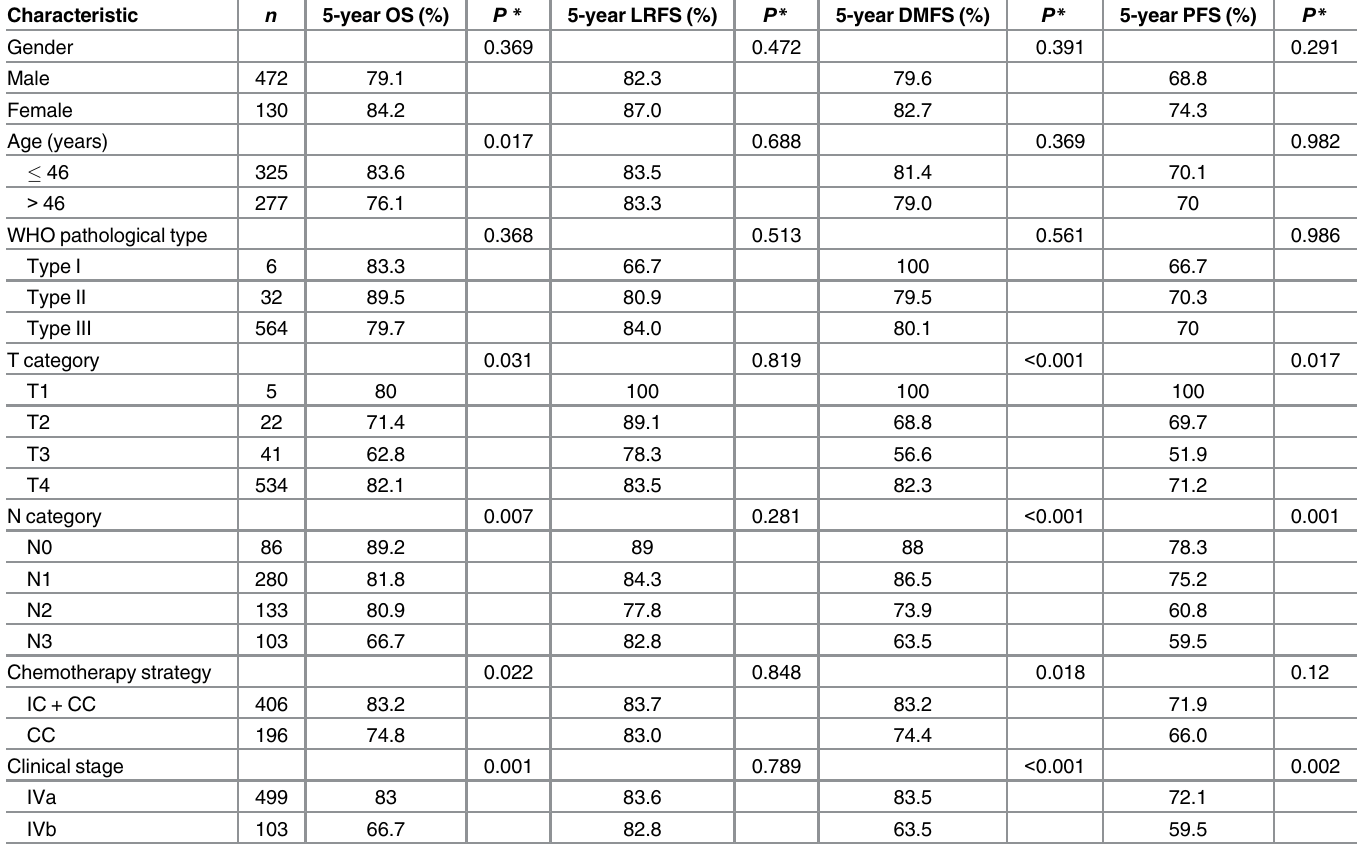
Table 3. Summary of univariate analysis for prognostic factors in the 602 patients with stage IVa-b nasopharyngeal carcinoma.